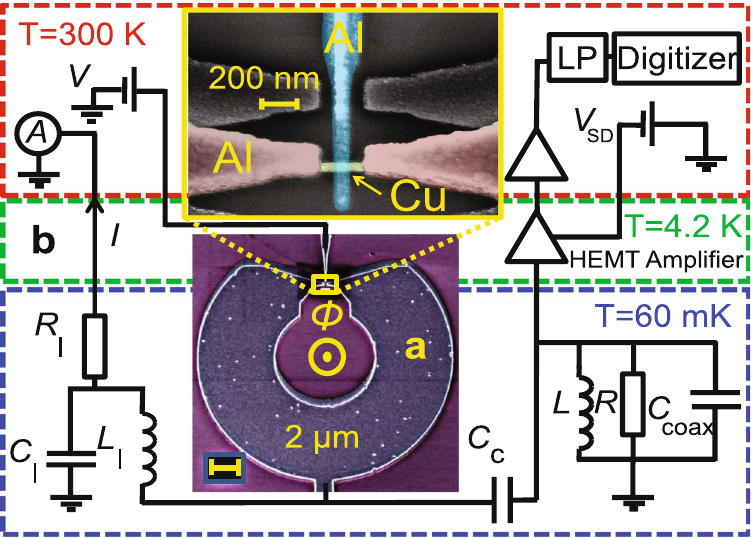
Figure 1. Typical sample and the noise measurement setup. (a) False color scanning electron micrograph of the SQUIPT device, together with a zoomed-in view of the Cu island (green) embedded in the superconducting Al loop (brown). The Al tunnel probe (blue) contacts the middle of the proximity SNS junction. (b) Schematic view of the DC and noise measurement system in the dilution refrigerator. Fluctuations of current through the sample are converted to voltage noise at the HEMT amplifier input by a resonant circuit formed mainly by the inductors L and L l on the sample holder, and the distributed cable capacitance C coax that connects the sample to the cryogenic amplifier residing directly in the helium